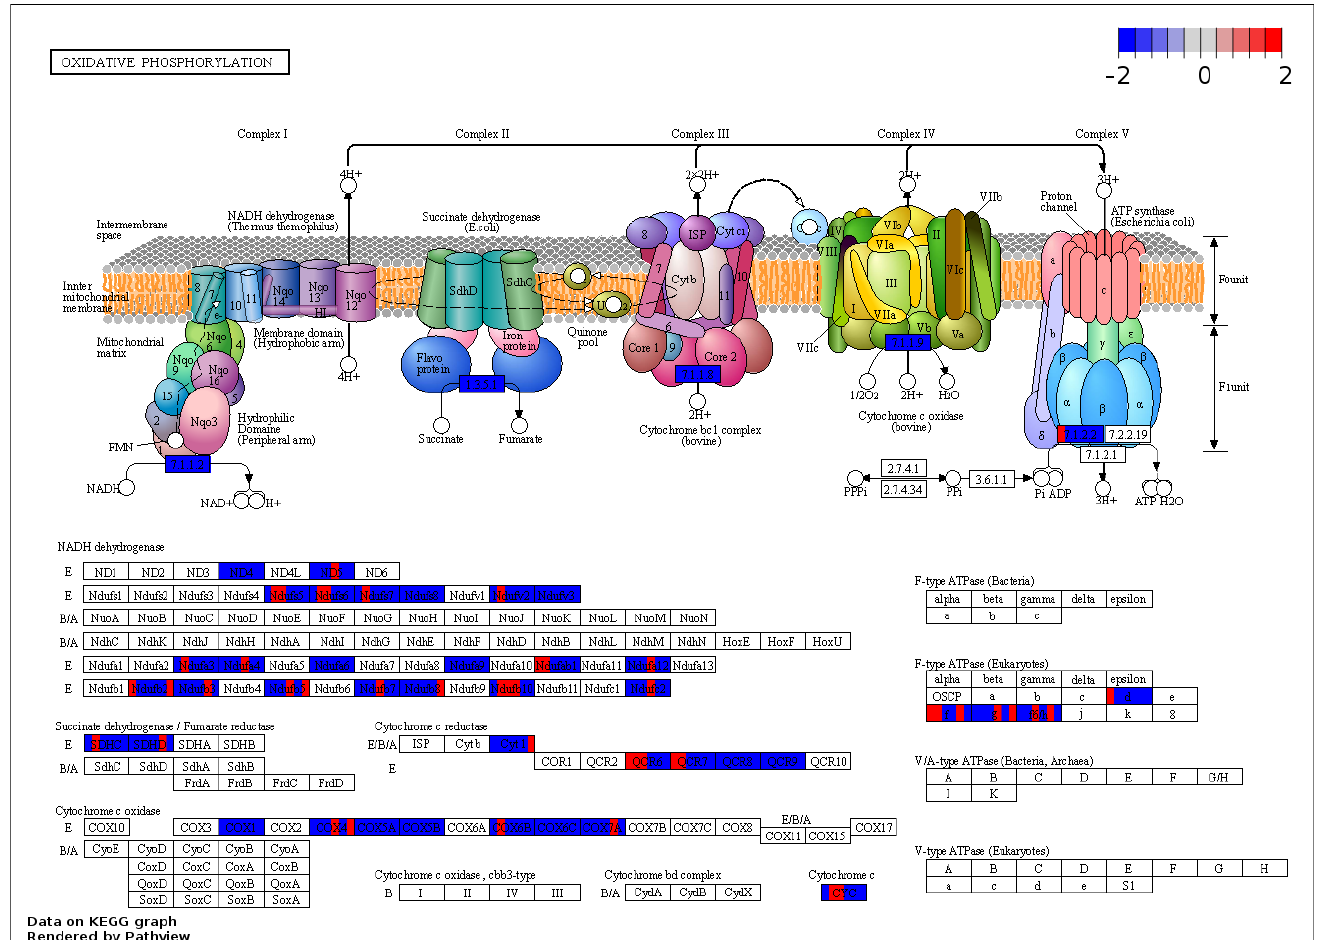
Figure 6. KEGG analysis showed concordant downregulated expression changes in protein components of the respiratory chain in the hypercholesterolemic left ventricle. Visual representation of leading-edge protein subsets based on the Kyoto Encyclopedia of Genes and Genomes database. Each protein was divided into six sections and was colored based on the relative expression count compared with the normocholesterolemic group. Pathway graphs were created with Pathview Web (https://pathview.uncc.edu/home accessed on 17 January 2022).